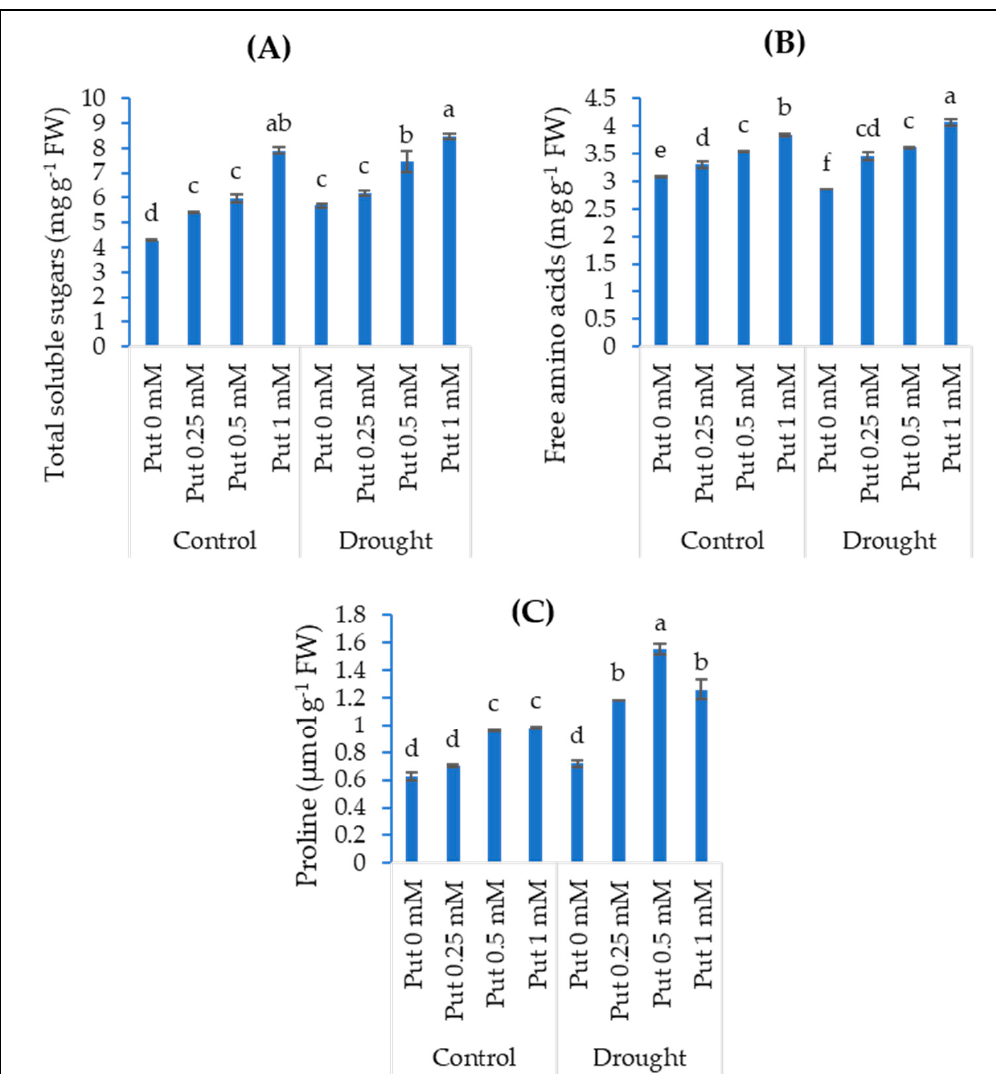
Figure 2. Change in soluble sugars ( A ), free amino acids ( B ), and free proline levels ( C ) in wheat plants pretreated with putrescine, drought stressor, and their combination. Each bar shows mean ± standard error. Different letters indicate different significance between means.